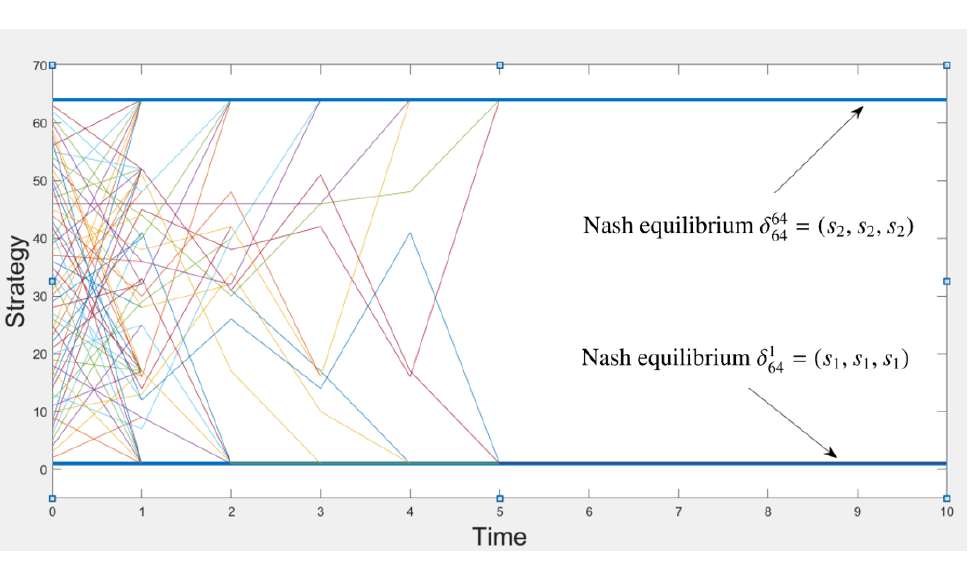
Figure 2. Dynamics of G p